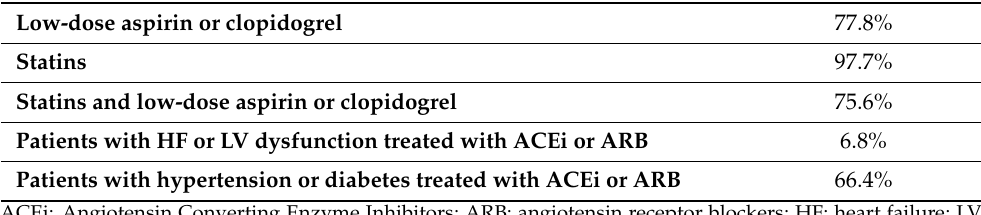
Table 5. Adherence to 2013 ESC guidelines recommendations about the use of cardiovascular prevention